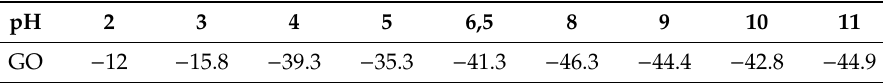
Table 2. Zeta potential analysis of purified graphene